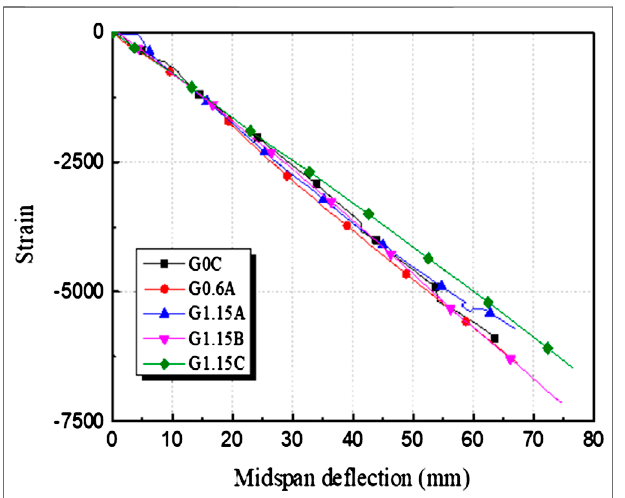
FIGURE 12 | Load-midspan de fl ection curves (specimens G0C, G0.6A, and G1.15C).